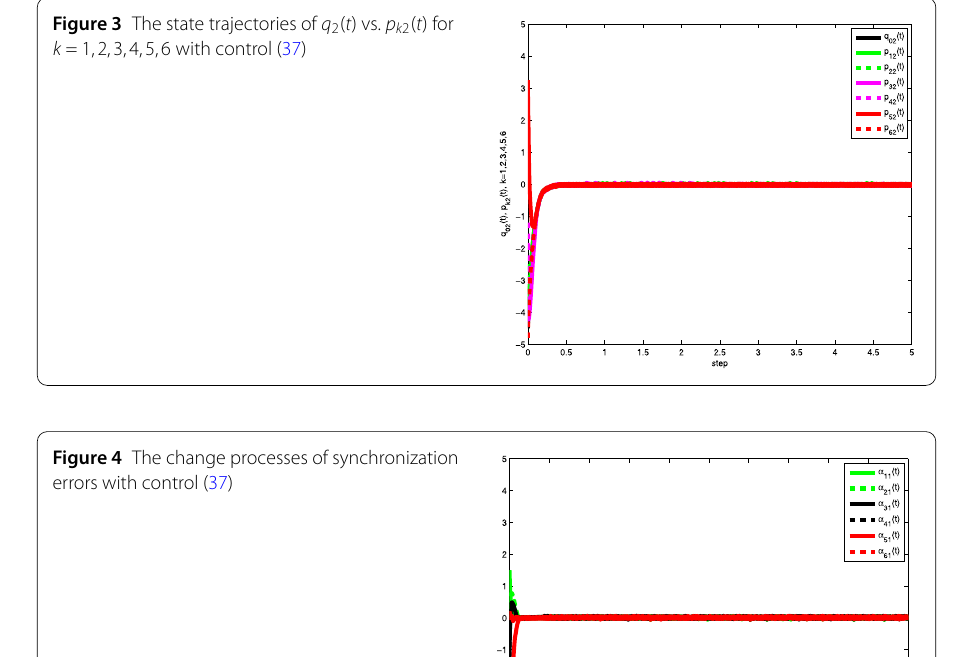
Figure 4 The change processes of synchronization errors with control (37)